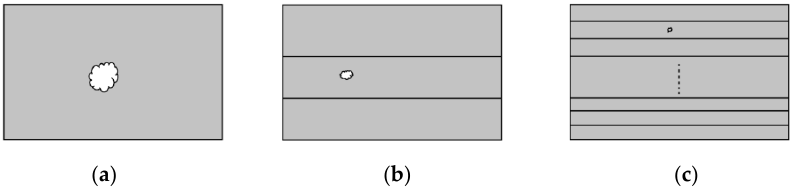
Figure 6. Schematics of void in solid dielectric with equal thickness. ( a ) Bulk material; ( b ) material composed by thick films; ( c ) material composed by thin